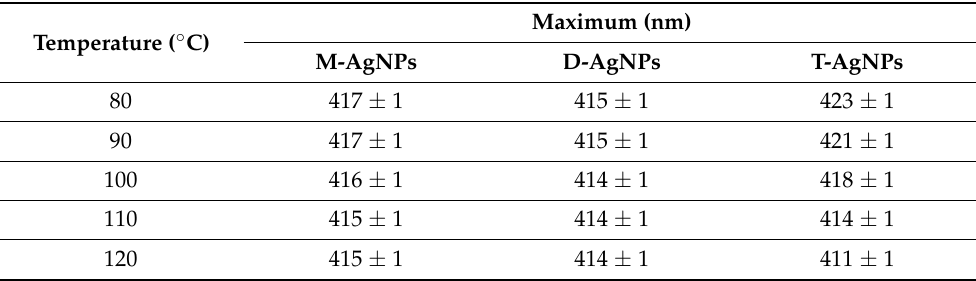
Table 1. Maxima of the surface plasmon resonance spectra of M-AgNPs, D-AgNPs, and